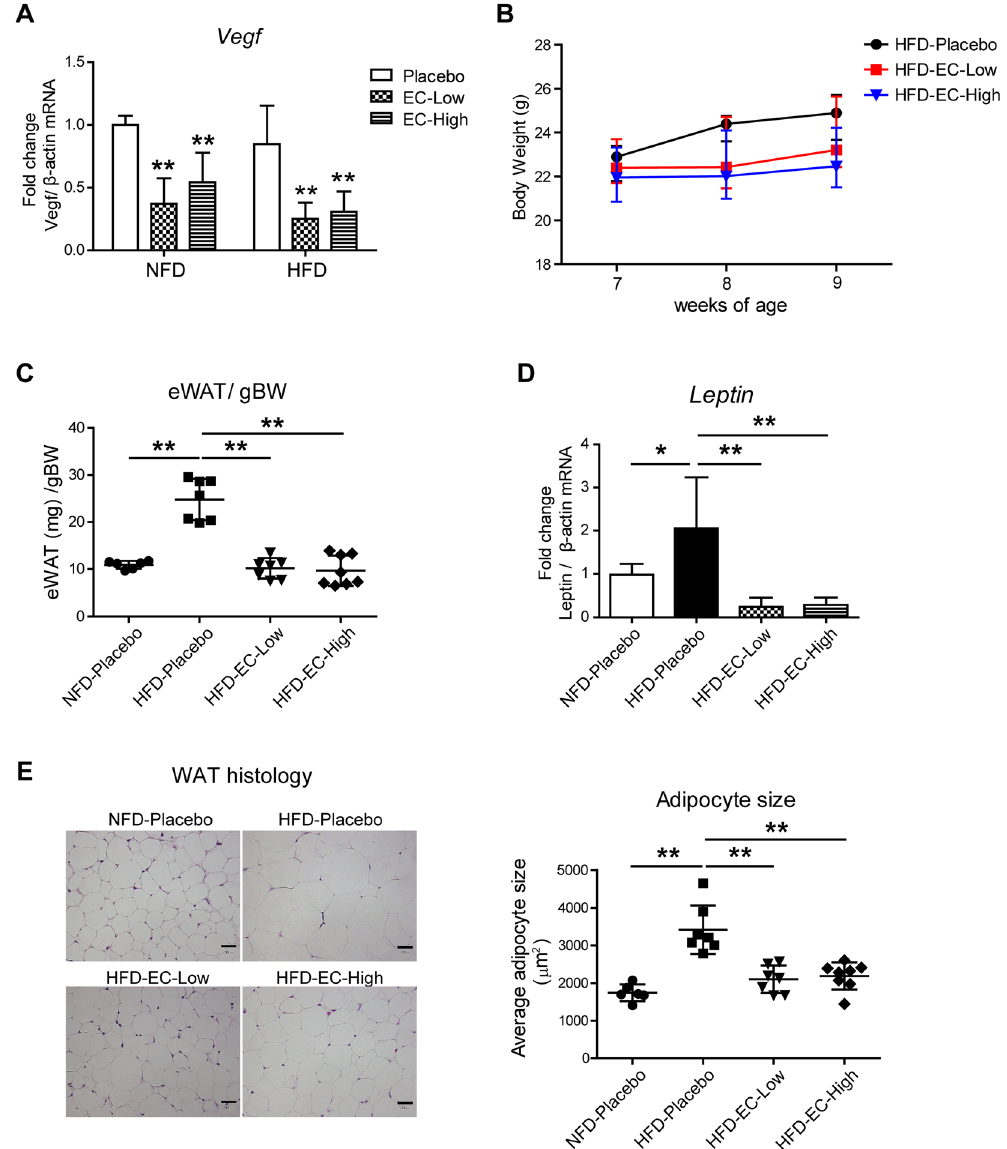
Figure 6. Echinomycin inhibits adipogenesis in high-fat diet mice. ( A ) qRT-PCR in eWAT for a HIF-1 target gene, vascular endothelial growth factor ( Vegf ) in either normal-fat diet (NFD) fed mice or high-fat diet (HFD) fed mice (n = 6–8 in each group). Echinomycin was administered intraperitoneally at two doses and frequency (EC-Low or EC-High). See the Method for further information. * * P < 0.01, as determined by a two-way ANOVA with Bonferroni’s post-test. ( B ) Body weight (BW) change in HFD fed mice groups. Echinomycin inhibited the BW gain (n = 6–8). ( C ) eWAT (mg)/BW in each group (n = 6–8). ( D ) qRT-PCR of leptin in eWAT (n = 6–8). * * P < 0.01, as determined by a two-way ANOVA with Bonferroni’s post-test. ( E ) H&E staining and average size of adipocyte from eWAT (n = 6–8). Scale bar 30 um. * * P < 0.01, as determined by a two-way ANOVA with Bonferroni’s